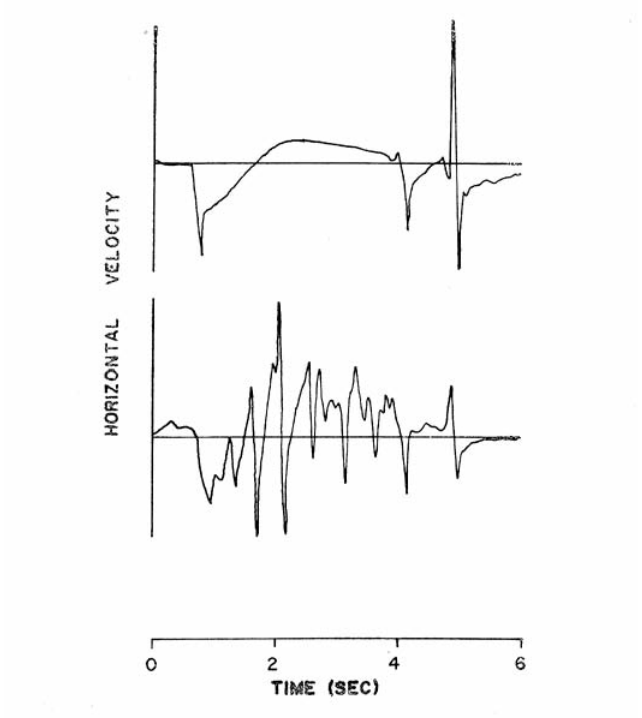
Figure 12. Synthetic horizontal particle velocities at Pacoima Dam obtained from the displacements shown in Figure 11. The upper trace corresponds to the case of uniform dislocation and the lower trace to the case of multiple cracks. Reproduced from Bouchon